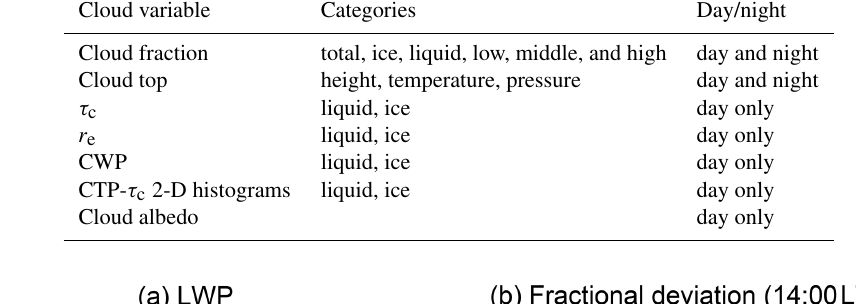
Table 1. The cloud variables produced by the simulator. The middle column specifies the separate categories available for each variable, and the third column indicates under which illumination conditions the variables are available.